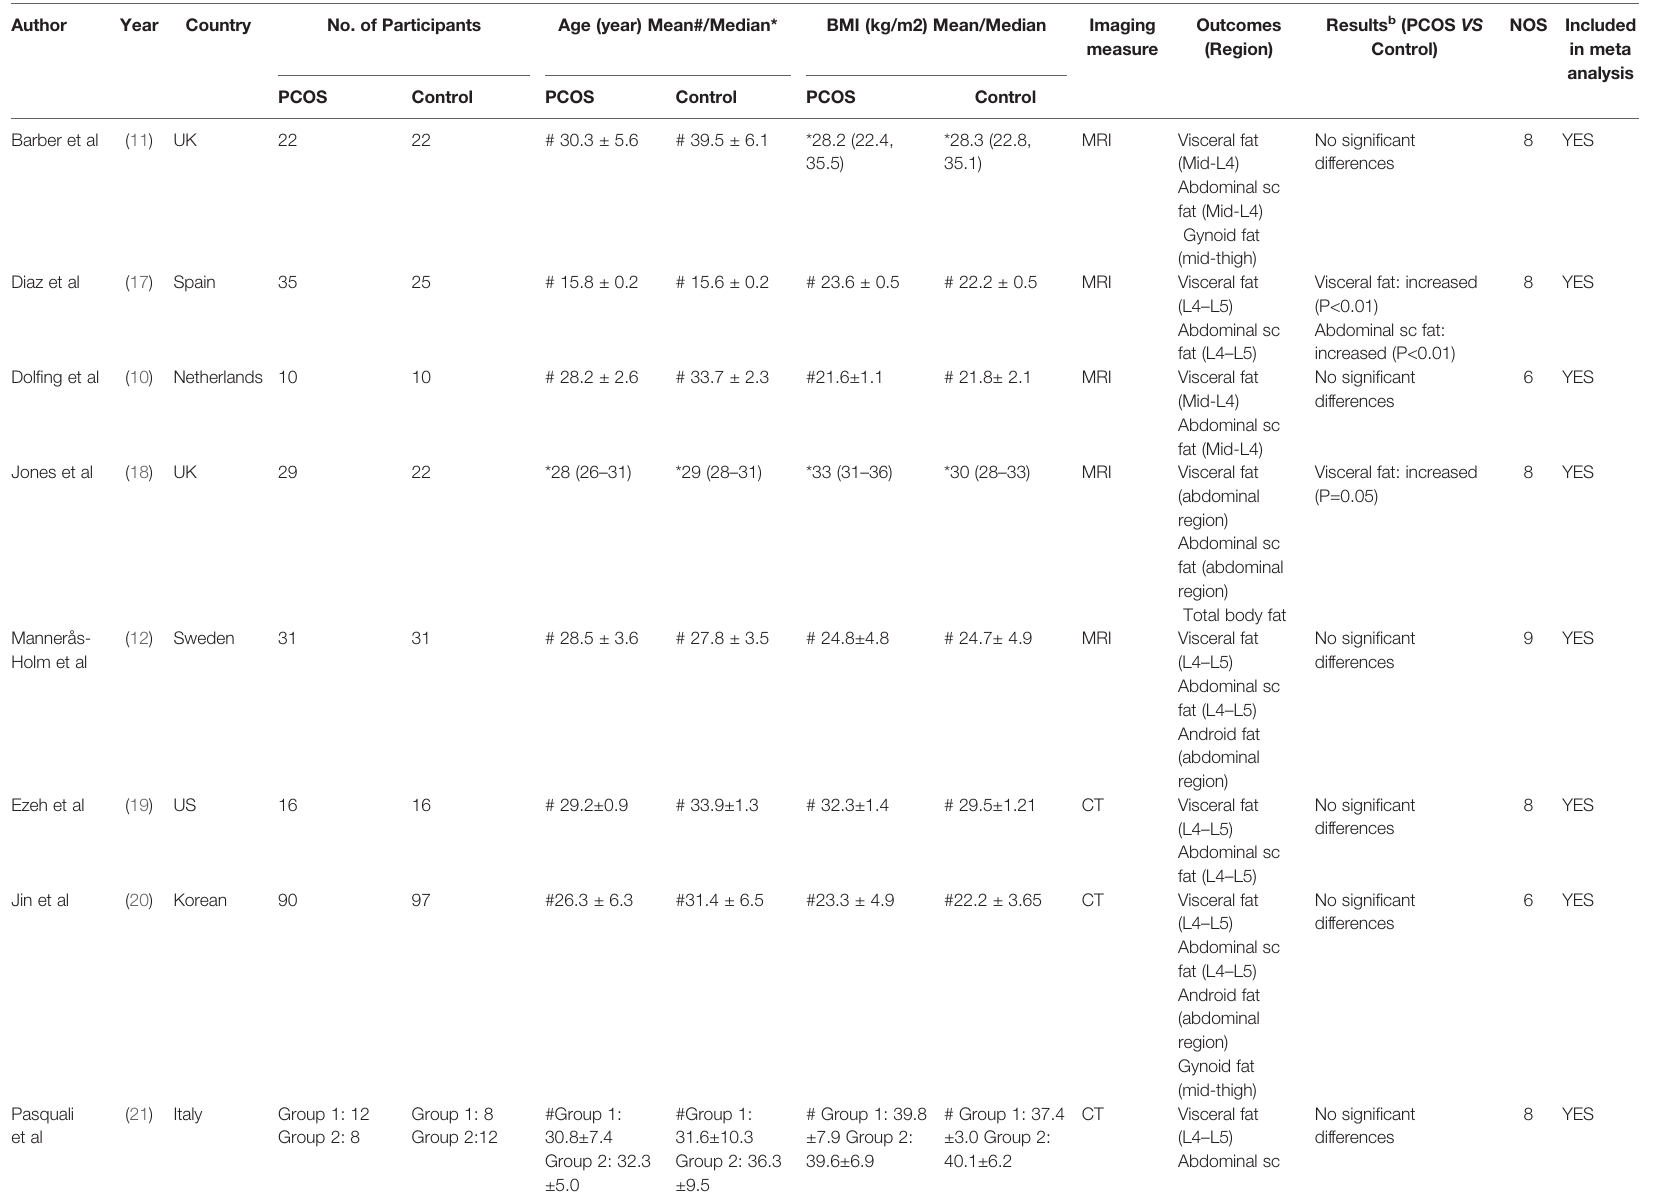
TABLE 1 | Study characteristics of included